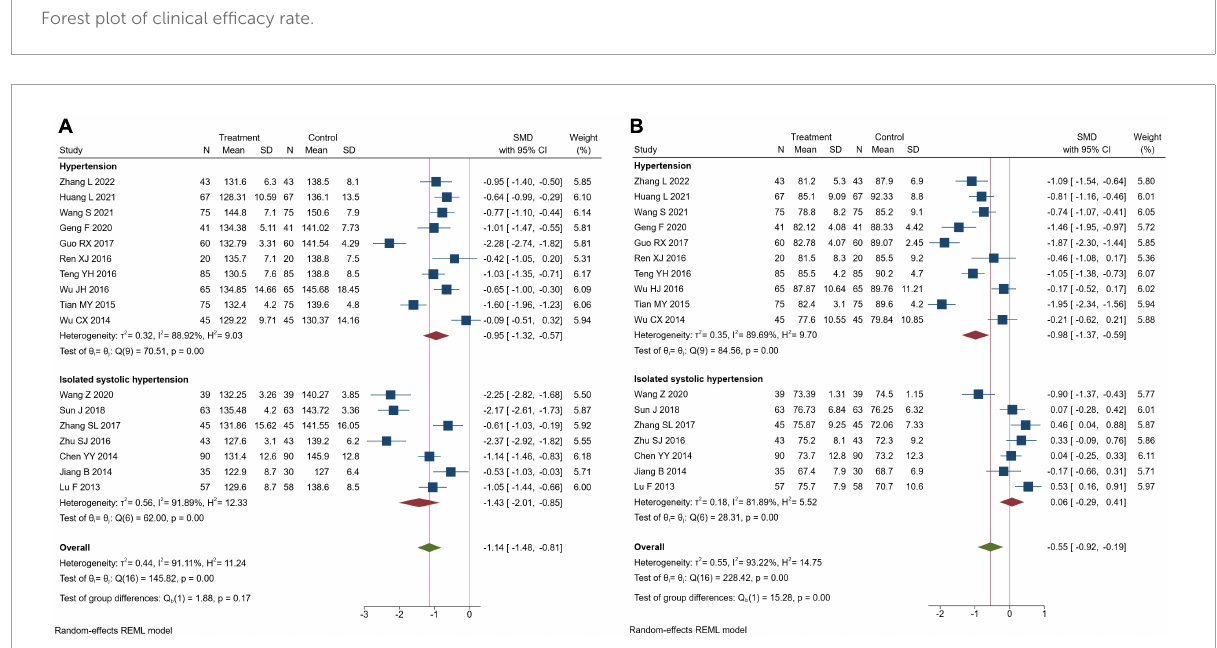
FIGURE4 Forest plot of blood pressure. (A) Systolic blood pressure; (B) diastolic blood pressure.